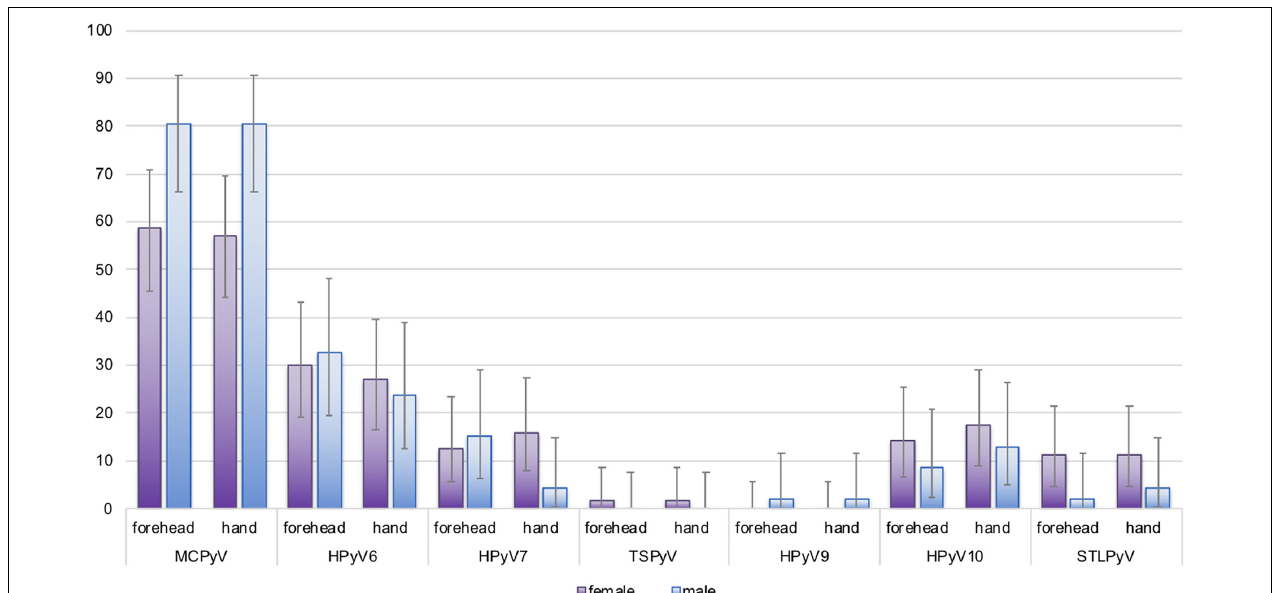
FIGURE 2 | Site-specific human polyomavirus (HPyV) baseline prevalence by sex. Y-axis: prevalence in percentage (%) with error bars. Purple bars: females; blue bars: males. The difference in baseline prevalence between females and males was statistically significant for Merkel cell polyomavirus (MCPyV) (forehead, p = 0.022, hand p = 0.013; Fisher’s exact test,